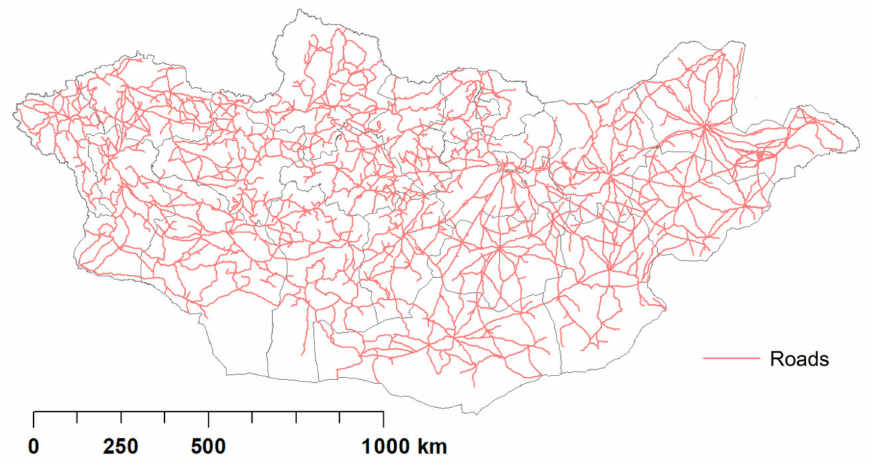
Figure 8. Main roads in